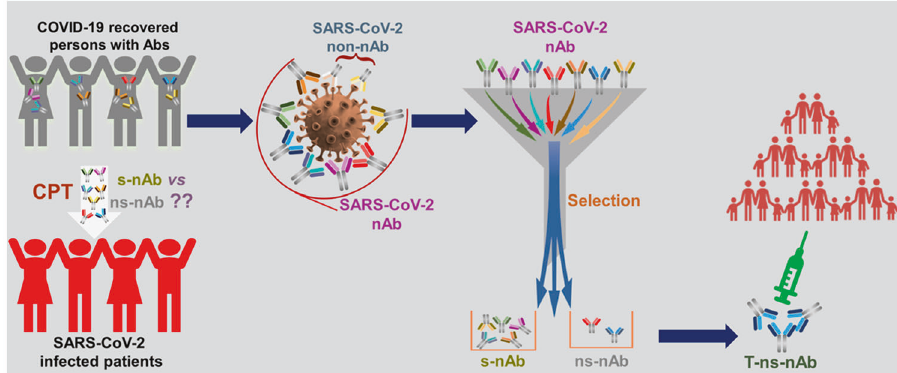
Fig. 1 Non-self-reacting antibodies and SARS-CoV-2 infection. Do the passive antibody supply strategy-based CPT require exclusion of autoreactive and non-nAbs, and retention of Abs with non-self-reactive-neutralizing activity to improve ef fi cacy? (left). Non-self-reactive- neutralizing antibody proposed to be a potent therapy for inhibiting the SARS-CoV-2 activity (right). CPT convalescent plasma therapy, nAb neutralizing antibody, s-nAb self-reactive-neutralizing antibody, ns-nAb non-self-reactive-neutralizing antibody, T-ns-nAb therapeutic non-self- reactive